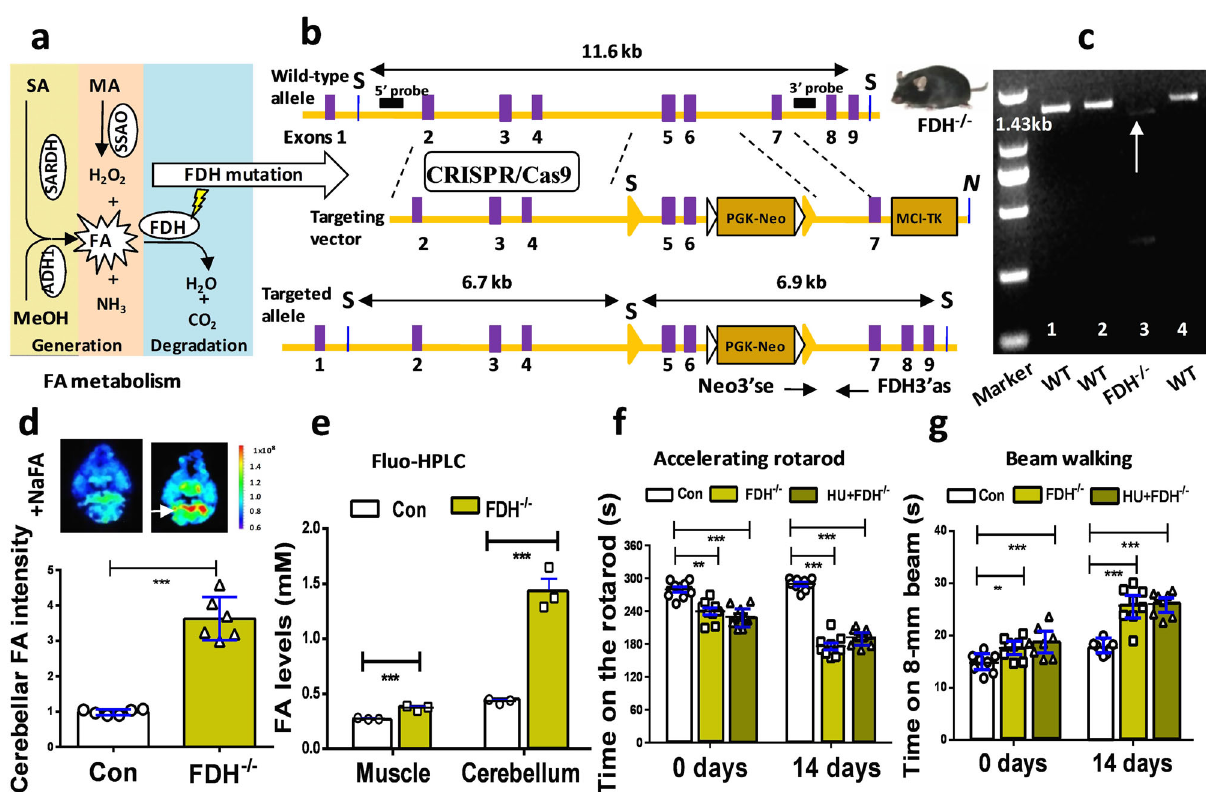
Fig. 4 Knockout of FDH induced the accumulation of systemic formaldehyde and motor de fi cits. a Metabolic pathways of formaldehyde including: formaldehyde generation by sarcosine dehydrogenase (SARDH), semicarbazide-sensitive amine oxidase (SSAO), and alcohol dehydrogenase 1 (ADH1); and degradation by formaldehyde dehydrogenase (FDH). SA sarcosine, MA methylamine, MeOH methanol, FA formaldehyde. b Technology roadmap of making FDH − / − mice by using the CRISPR/Cas9 method to delete the exons- 5 and 6. c FDH − / − mice identi fi ed by RT-PCR (target band, 1.43 kb). WT wild-type mice, FDH − / − the FDH -knockout mice. d Cerebellar formaldehyde quanti fi ed by an in vitro small animal imaging system ( n = 6). e Formaldehyde levels in the muscle and cerebellum detected by Fluo-HPLC ( n = 3). Fluo-HPLC high-performance liquid chromatography with a fl uorescence detector. f Motor behaviors assessed by the accelerating rotarod test ( n = 9). HU hindlimb unloading. g Motor functions evaluated by the beam walking test ( n = 8). Error bars show the mean ± SEM; ** p < 0.01; *** p <